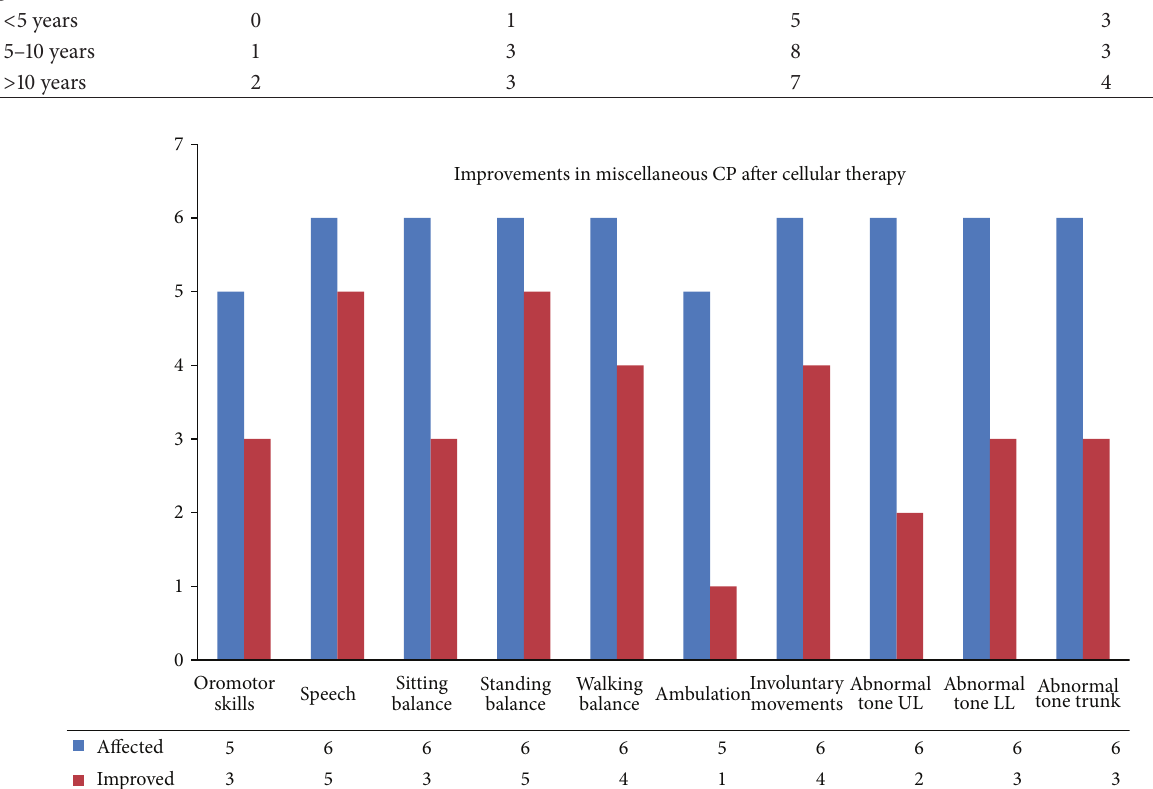
Figure 3: Improvements in miscellaneous group of CP: graph demonstrating symptomatic improvements in miscellaneous group of cerebral palsy after cellular